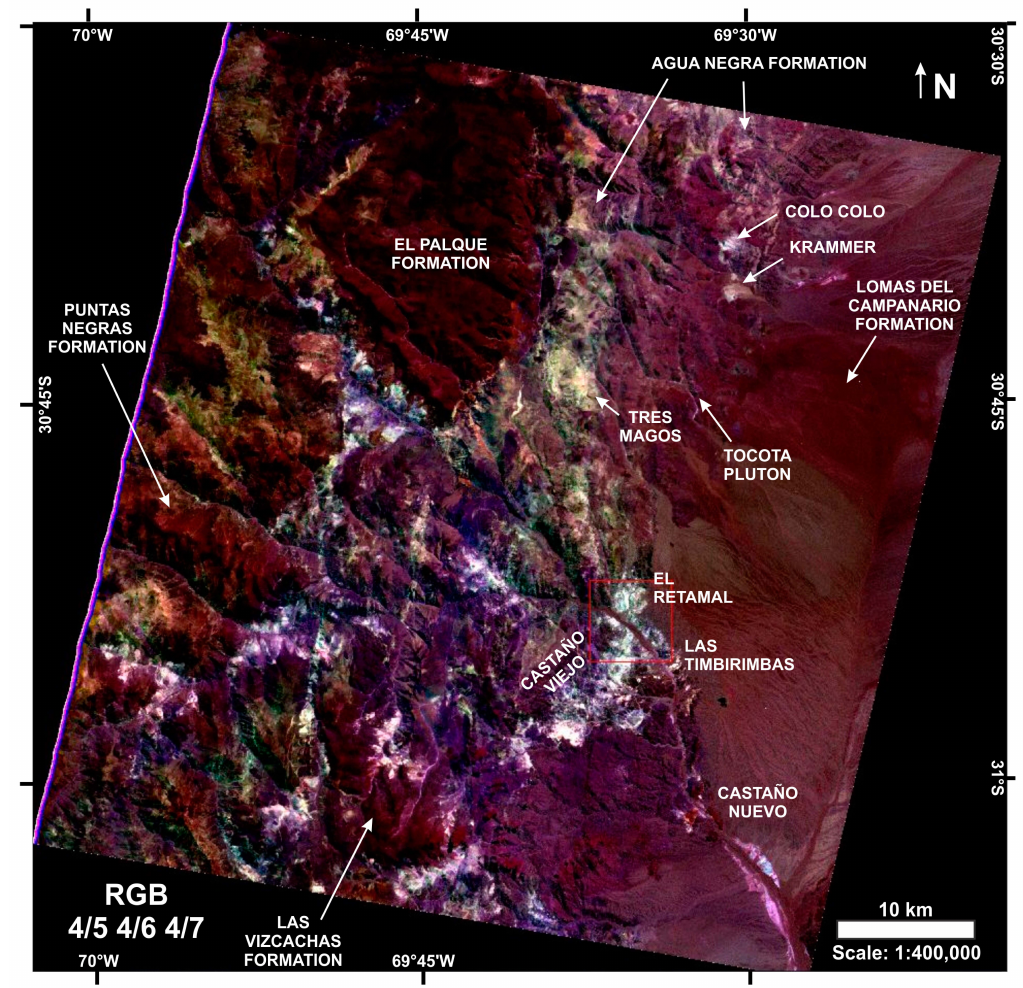
Figure 8. The ASTER false color composite image of RGB band ratios 4/5, 4/6, 4/7 represents a good discriminator of lithologic units (cf. Figure 3) and alteration types. It identifies the El Palque, Puntas Negras, Lomas del Campanario and Las Vizcachas formations and the Tocota Pluton (maroon shades). It differentiates the hydrothermal clays and micas (bluish white) from the mica- and clay-rich facies of Agua Negra Formation (greenish